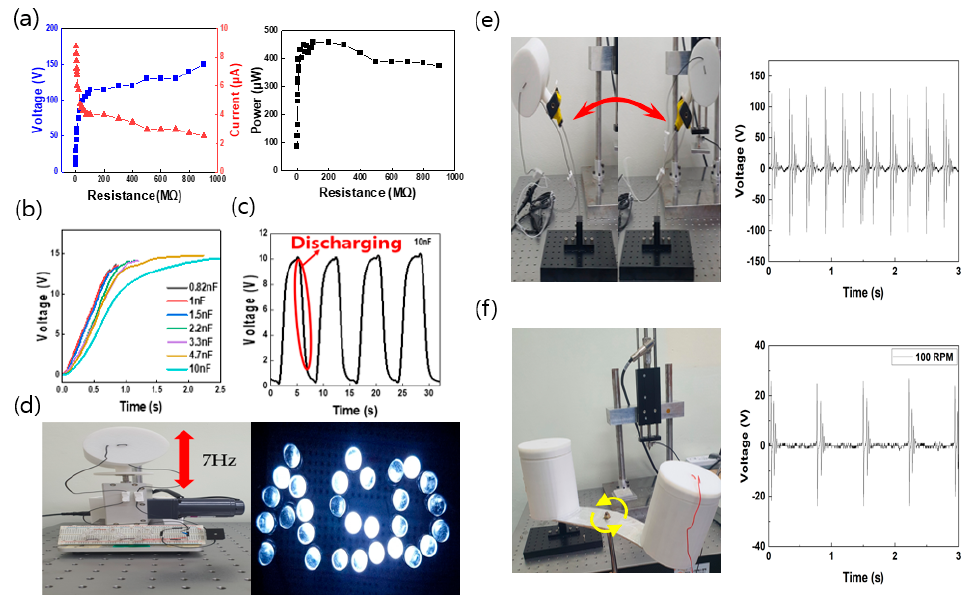
Figure 7. Application: ( a ) Plots depicting the influence of load resistance on the P-TENG, ( b ) plot depicting the use of capacitors with different capacitance values (0.82, 1, 1.5, 2.2, 3.3, 4.7, and 10 nF), ( c ) plot of the curve of charge/discharge when two LEDs were connected, ( d ) image of the “ASD” pattern LED by the P-TENG (photograph of the digital speed controller and electrical circuit configuration), ( e ) pendulum kinetic energy , and ( f ) rotational kinetic energy .